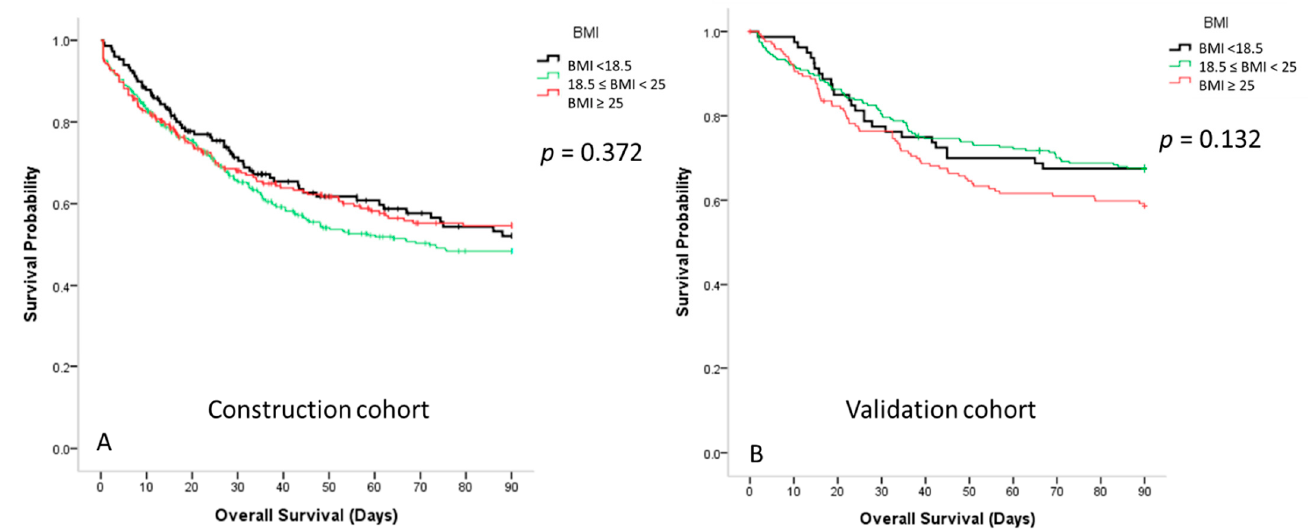
Figure 3. ( A ) Survival curves for the patients with sepsis in the medical intensive care unit according to the body mass index (BMI) in the construction cohort; ( B ) survival curves for the patients with sepsis in the medical intensive care unit according to the body mass index in the validation cohort.